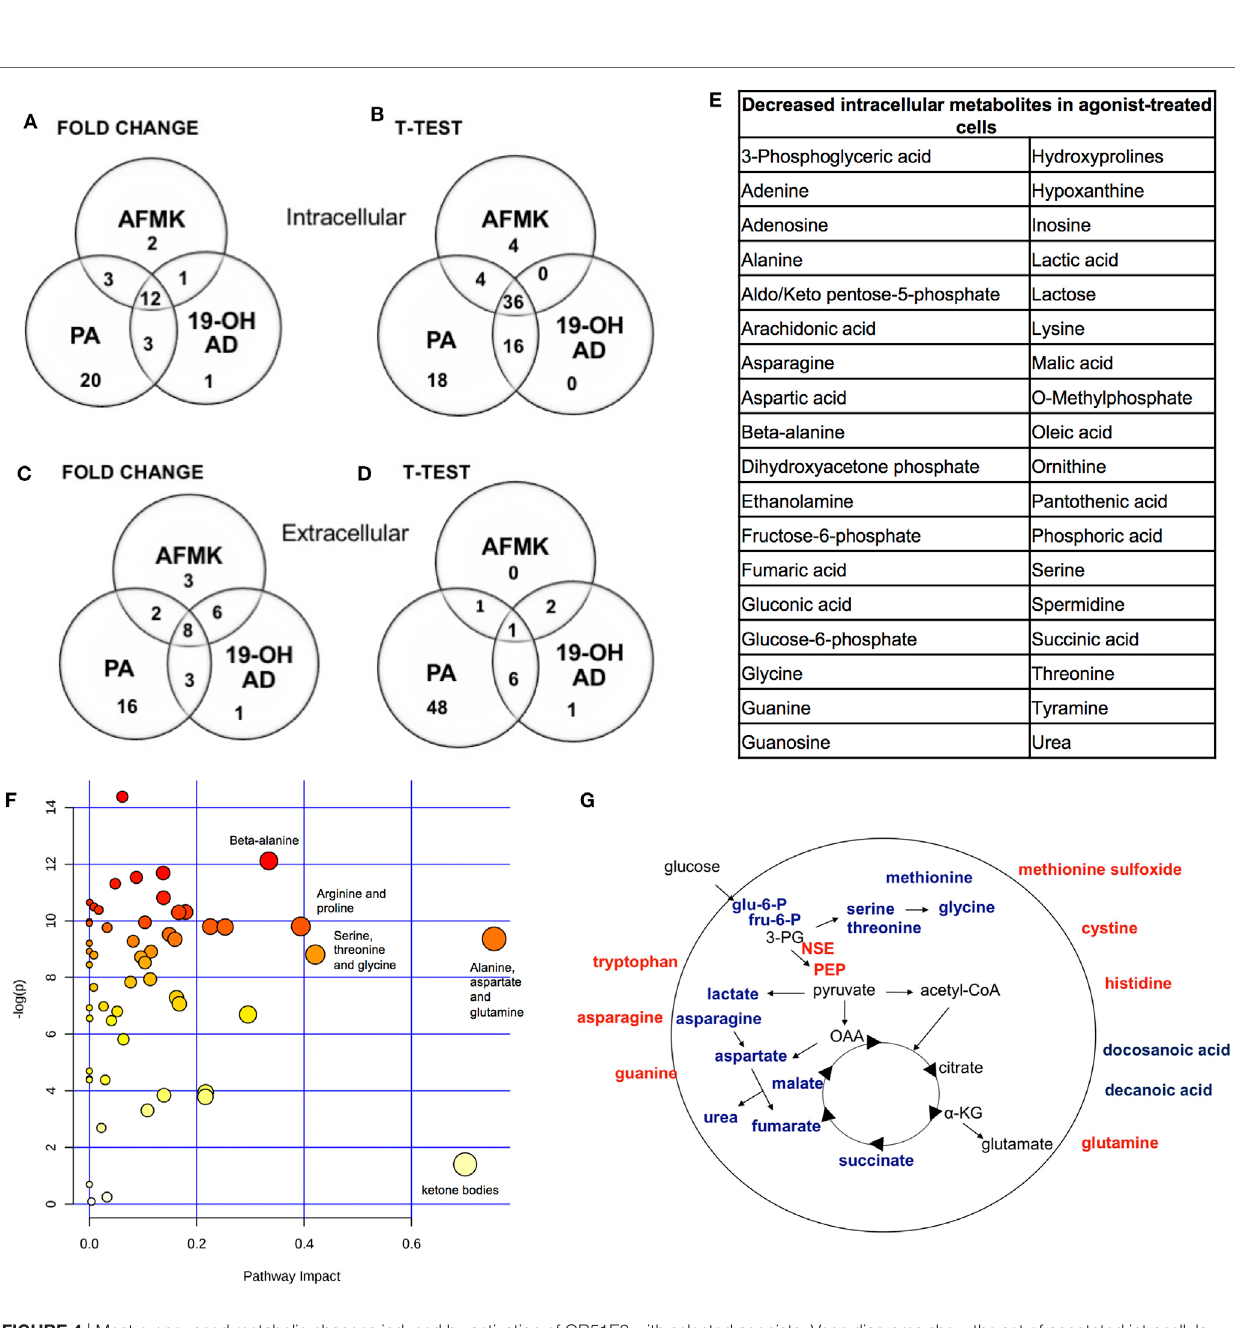
FigUre 3 | Agonist treatment of LNCaP cells results in robust metabolomic signatures. The top 15 extracellular metabolites were identified after stimulation with (a) 19-OH AD, (B) acetyl- N -formyl-5-methoxykynurenamine (AFMK), and (c) propionic acid (PA). The top 15 intracellular metabolites were identified after stimulation with (D) 19-OH AD, (e) AFMK, and (F) PA. Heatmaps are based on the Pearson correlation analysis (Ward) and indicate annotated metabolites identified by t -test (